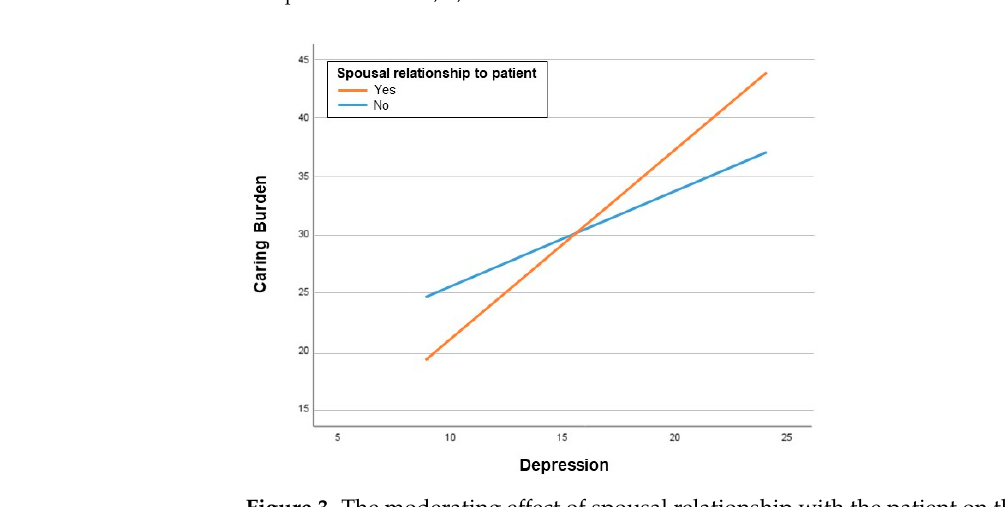
Figure 3. The moderating effect of spousal relationship with the patient on the correlation between depression and caring